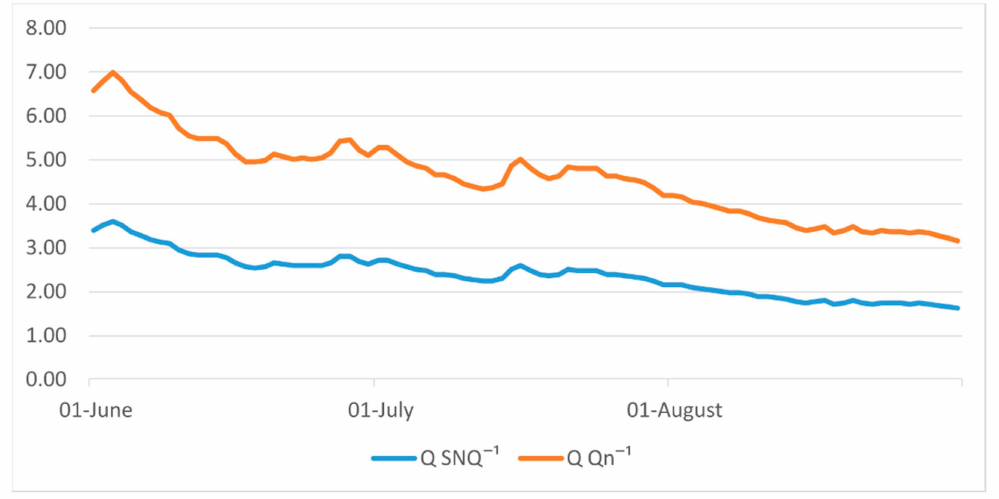
Figure 12. Relative water flow in the Wisła River (Szczucin) about the SNQ and Q n